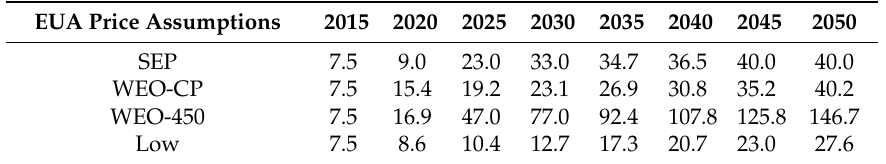
Table 2. EUA price assumptions ( € 2012/t CO 2